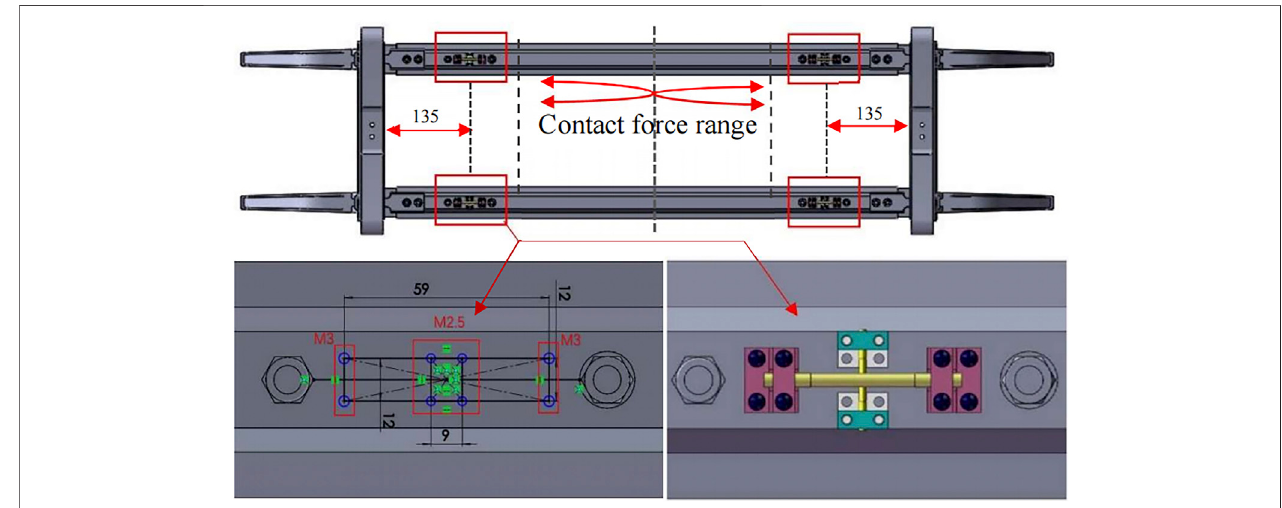
FIGURE 7 | Illustration of the sensor layout (bottom